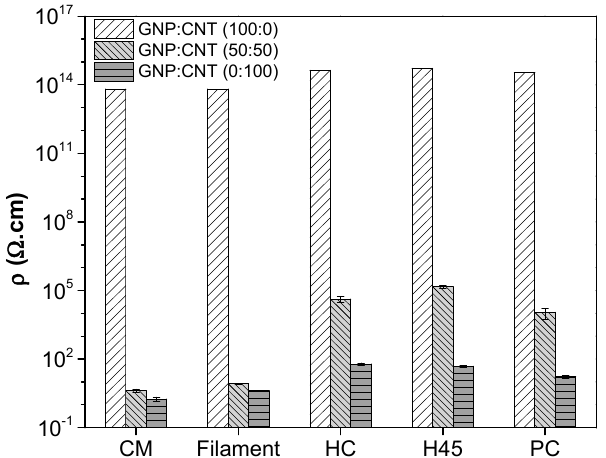
Figure 7. Electrical volume resistivity of GNP, CNT, and GNP/CNT nanocomposites with different processing: compression molding (CM), the filament, and FFF samples (HC, H45, and PC).